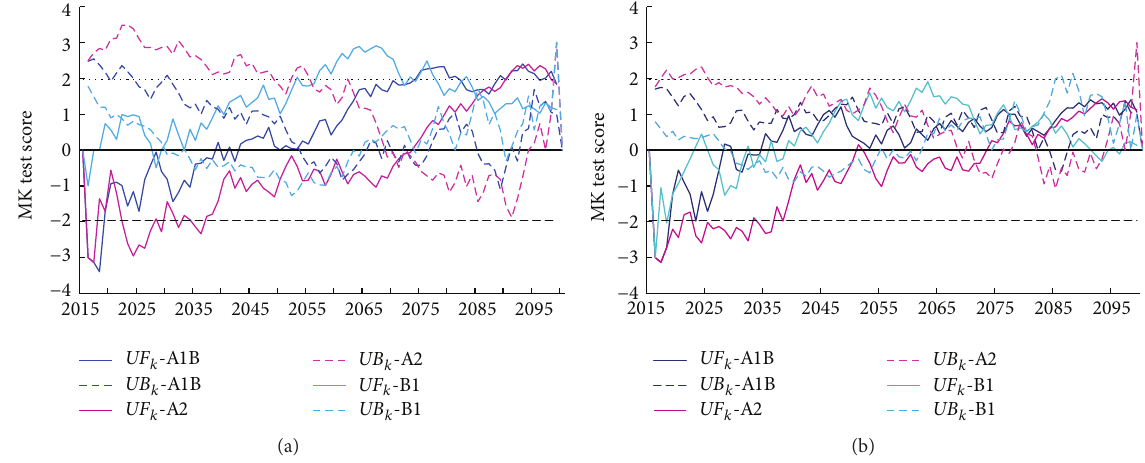
Figure 10: The MK test score of extreme precipitation from 2016 to 2100 under three climate change scenarios; (a) RX1day, (b)